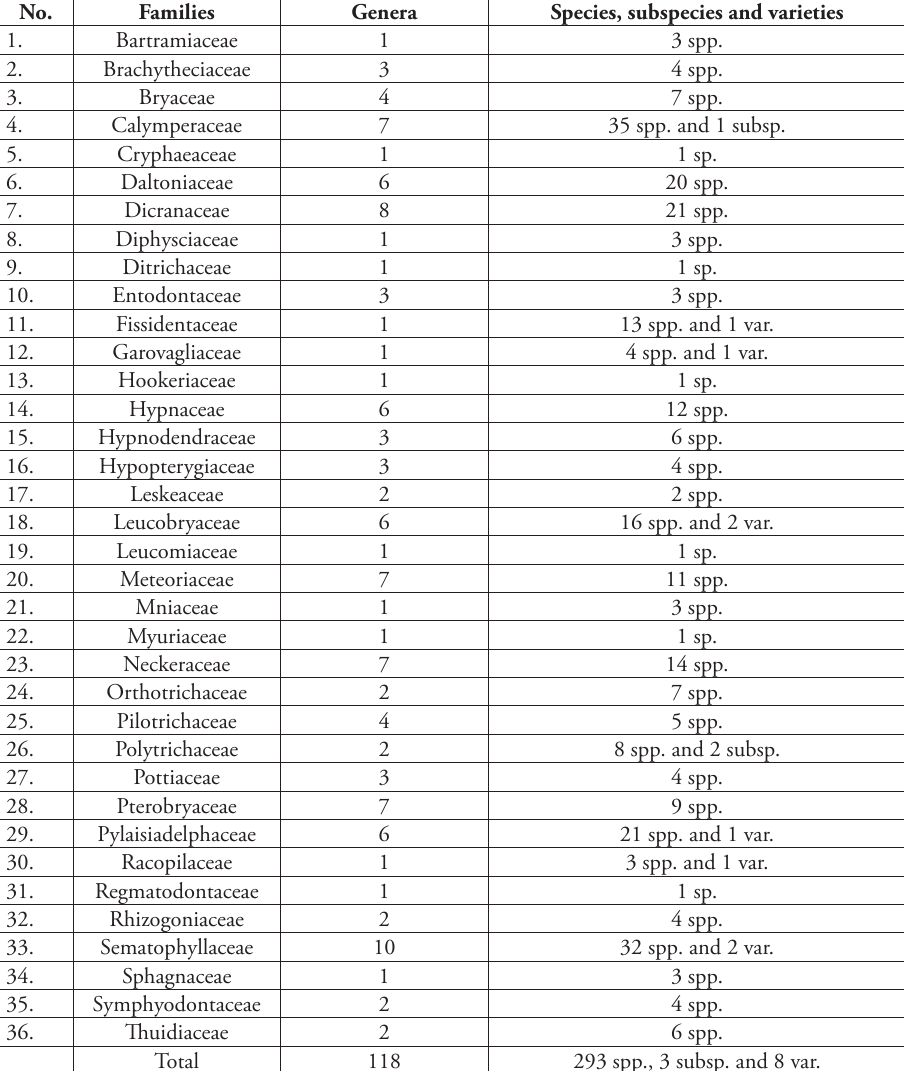
Table 2. Mosses reported from Crocker Range Park (See Appendix 1 for species checklist).